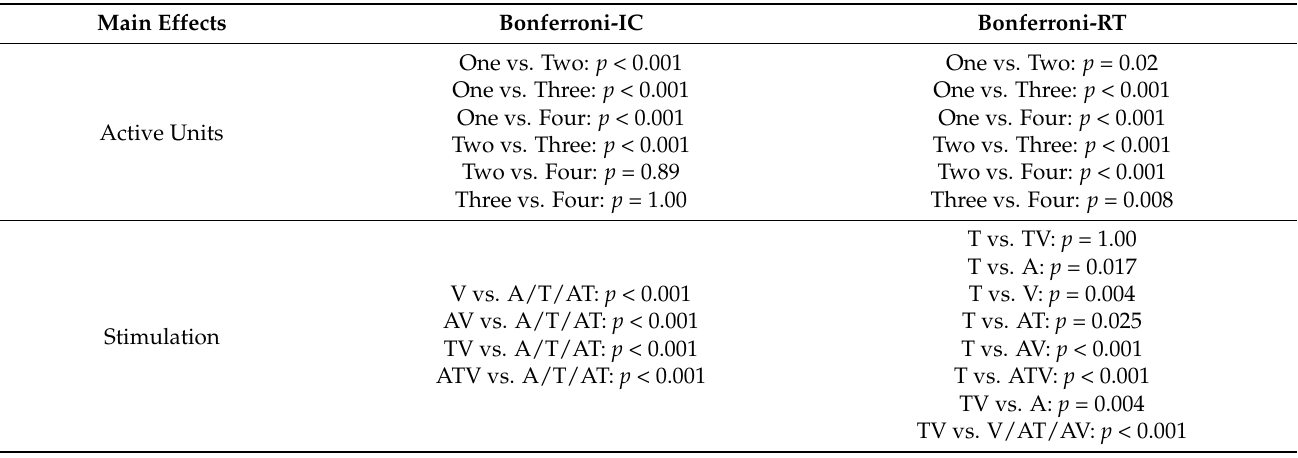
Figure 2. Impact of increasing stimulated area on index correct (IC) and reaction time (RT). The grey symbols represent the values of index correct (y-axis) between 0 and 1, as a function of Reaction Time (x-axis), expressed in seconds, per participant. The red asterisk is the average on the total number of participants. The black dashed lines indicate the chance level (0.25). The increase in the number of active units significantly resulted in a reduction of IC within 18.75 cm 2 ( p < 0.001), along with a linear increase of RT until 25 cm 2 ( p < 0.001). Table 1. Results with Bonferroni corrections. The table reports the results of the main effects and interaction effects for the index correct (IC) and responsiveness